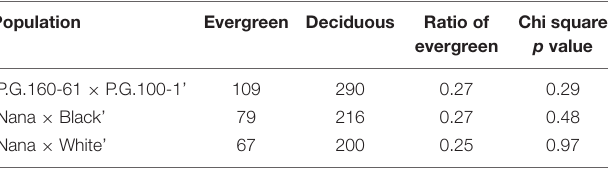
TABLE 1 | The distribution of the evergreen and deciduous phenotypes in three F2